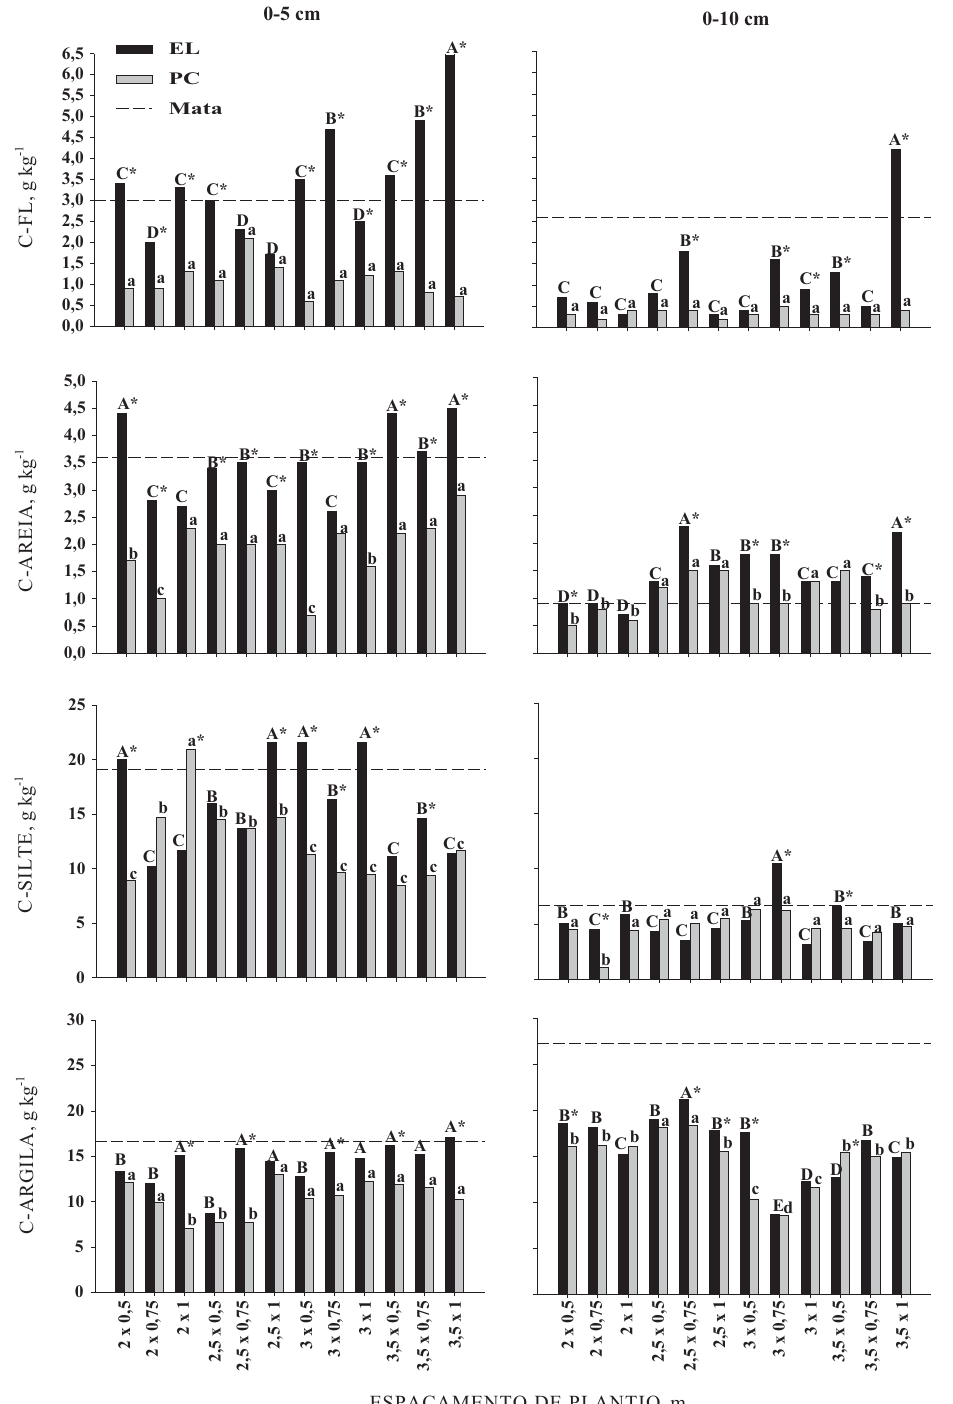
Figura 2. Teores de C nas frações leve (C ), areia (C-areia), silte (C-silte) e argila (C-argila) sob influência de FL diferentes espaçamentos de plantio de cafeeiro cultivado em um Latossolo Vermelho distroférrico. EL: amostras coletadas na entrelinha; PC: amostras coletadas na projeção da copa. Letras maiúsculas compararam os teores de carbono entre os diferentes espaçamentos de plantio, para as amostras coletadas na EL. Letras minúsculas compararam os teores de carbono entre os diferentes espaçamentos de plantio, para as amostras coletadas na PC. Médias seguidas da mesma letra não diferem entre si pelo teste de Scott-Knott (p < 0,05). *Compara os teores de C entre os locais de coleta de amostras (EL e PC), dentro de cada espaçamento de plantio. A presença do * designa média estatisticamente superior pelo teste F a 5